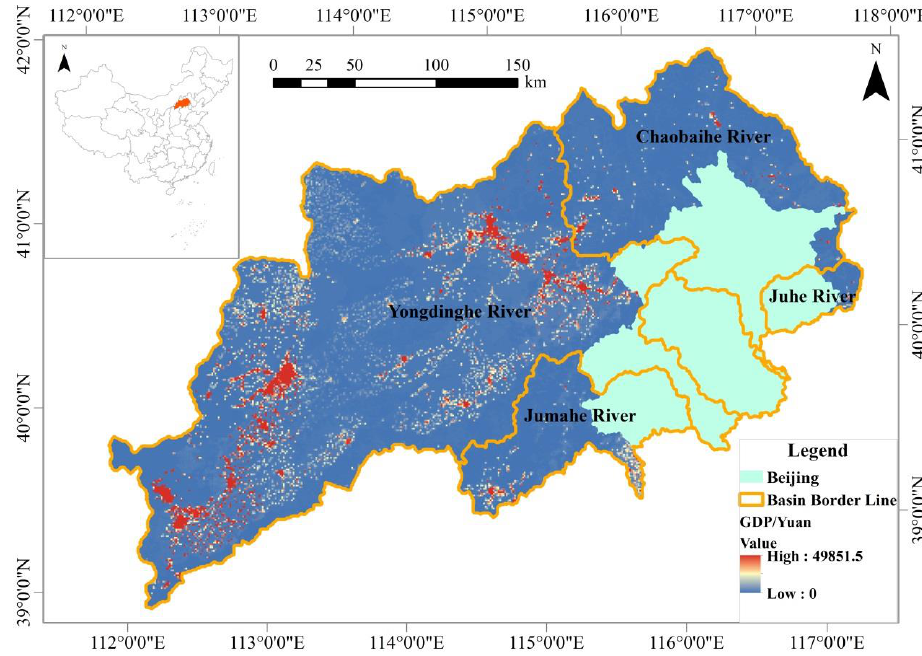
Figure 6. Spatial distribution of the GDP in the study area.